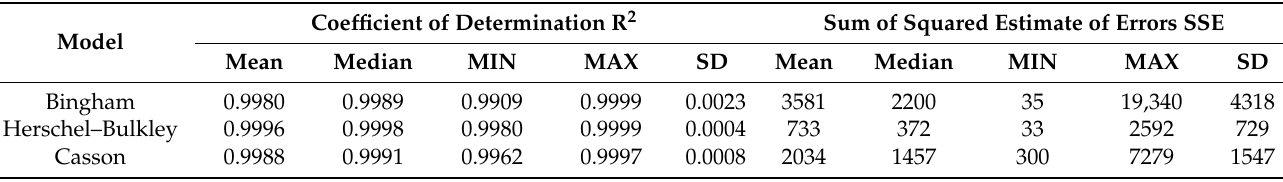
Table 5. Values of the statistical indicators of the rheological models ( n = 50).